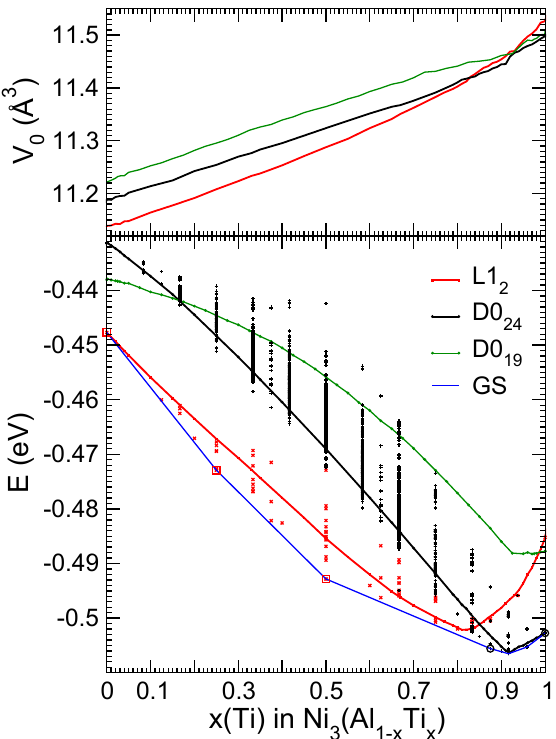
Figure 3. Equilibrium volumes V 0 [Å 3 /atom] and formation energies E [eV/atom] of Ni 3 (Al 1 − x Ti x ) 1 fully ordered structures (points) and phases with a homogeneous disorder on the Al/Ti sublattice (lines), based on L1 2 (red), D0 24 (black), and D0 19 (green) lattices. The ground-state (GS) hull is shown by the blue line, with marked L1 2 -based (red squares) and terminal D0 24 -based (black circles at x = 0.875 and 1) ground states. There are multiple GS candidates with spaced Al solute at 0.875 < x < 1.